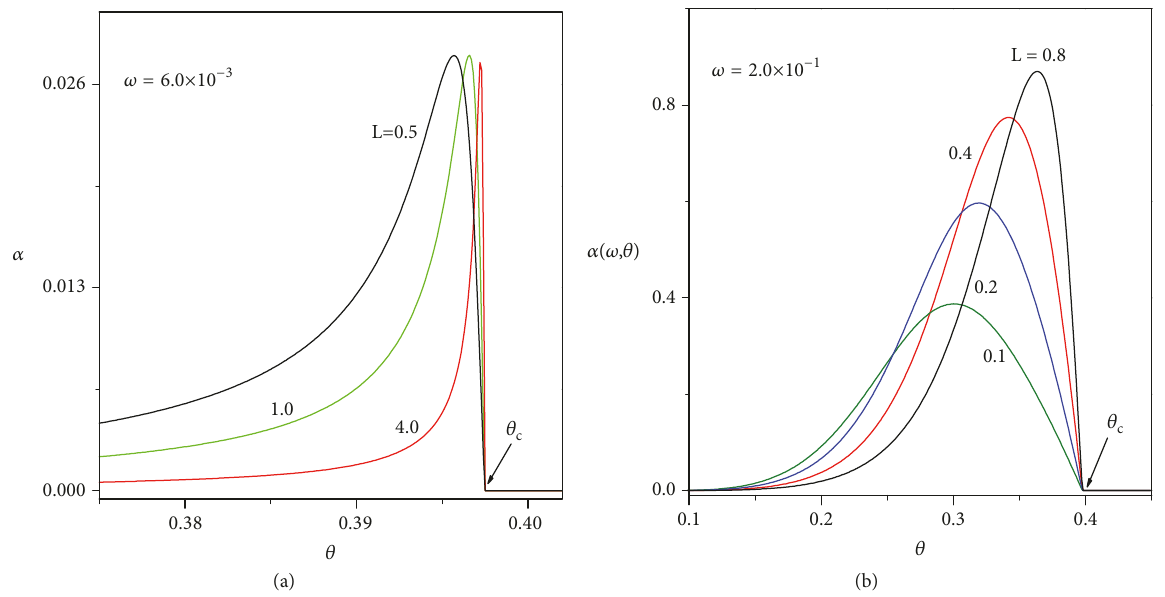
Figure 4: Ultrasonic attenuation as a function of reduced temperature for (a) 𝜔 = 0.006 and (b) 𝜔 = 0.2 while 𝑝 = 0.98 and 𝑑 = 𝑑 𝐶 = 0.45 . The number accompanying each curve denotes the value of the order parameter Onsager coefficient ( 𝐿 ) and the arrow denotes the critical